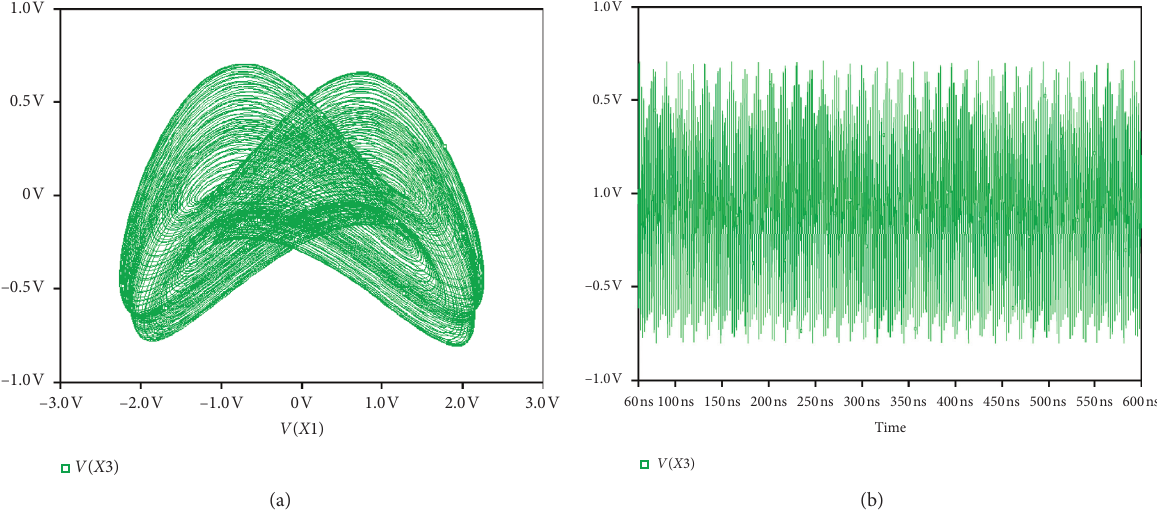
� 8 . 33334 k Ω , R 5